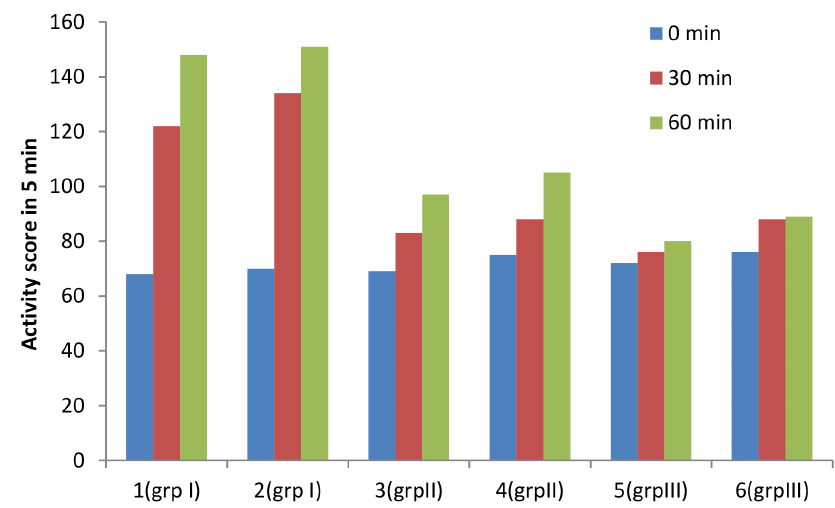
FIGURE 6 - Pharmacodynamic study by